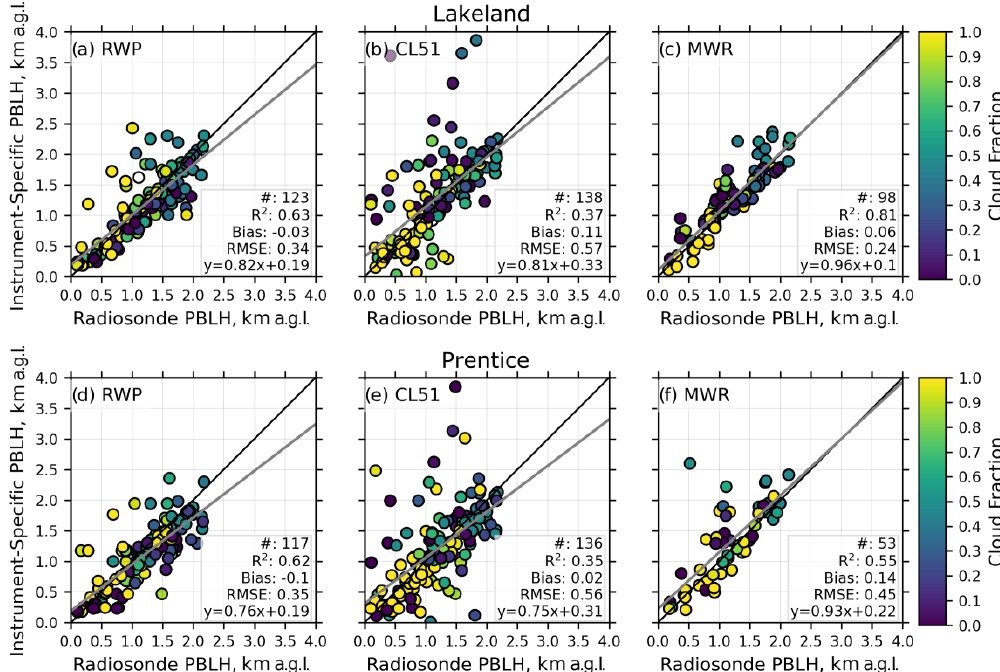
Figure 9. Comparisons of the PBLHs (comparisons at the Lakeland site are provided in a–c , and those at the Prentice site in d–f ) from the parcel method applied to the radiosonde virtual potential temperature profiles ( x axis) versus those estimated ( y axis) by the RWP fuzzy-logic method (a, d) , the CL51 QC-scaled approach (b, e) , and the parcel method applied to the MWR virtual potential temperature profiles (c, f) . Comparisons are categorized by the cloud fraction coverage (color bar). Black lines represent the 1-to-1 line, and grey lines represent the best-fit